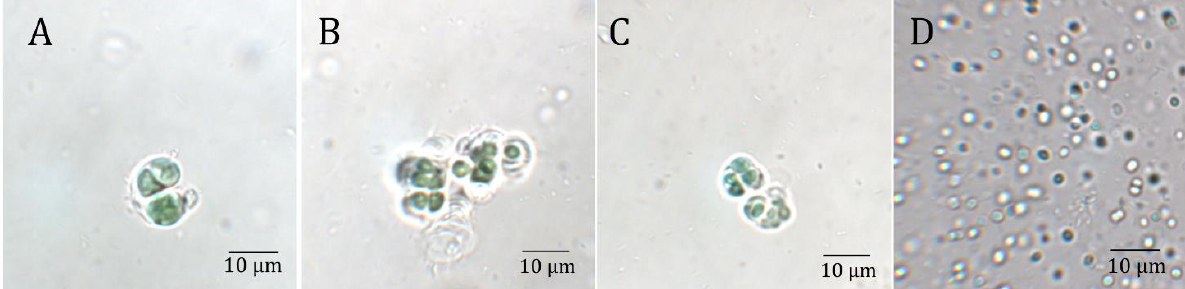
Figure 1. Light microscopy images of cyanobacterial isolates from several substrates and locations: ( A ) Sandstone from the Negev desert (S-NGV-2P1), ( B ) Calcite (C-VL-3P3) and ( C ) Gypsum (G-MTQ-3P2) from the Atacama Desert, and ( D ) M. aeruginosa isolated from Lake Tai, China.